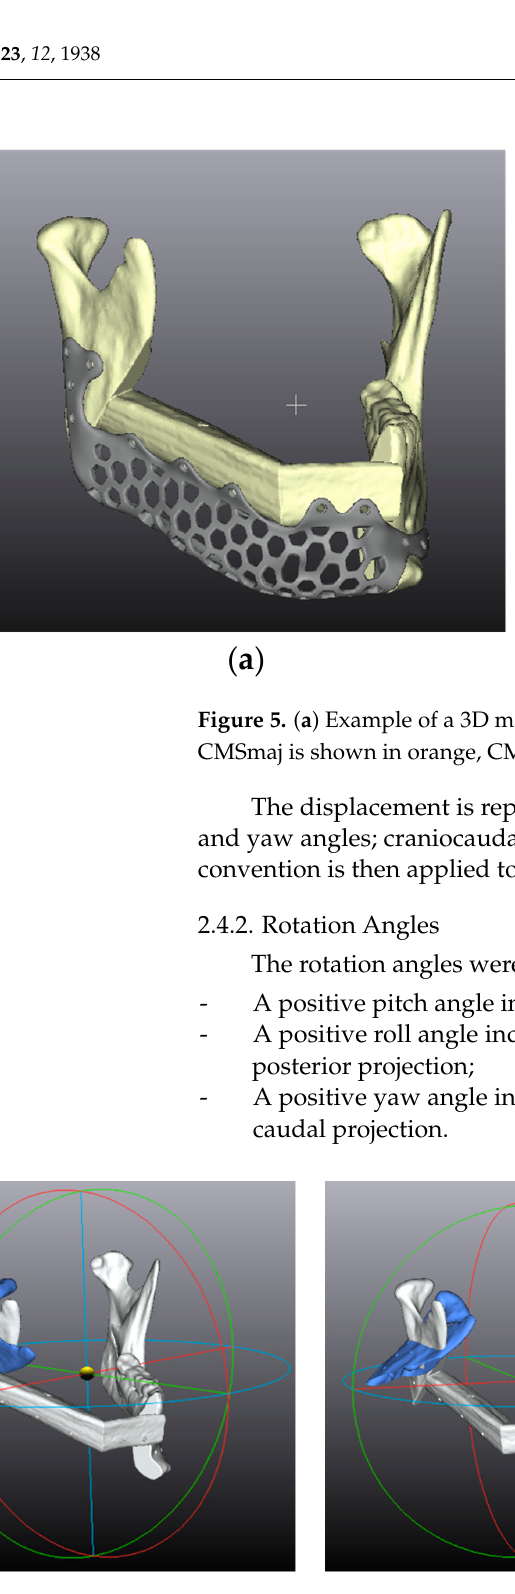
Figure 6. Examples of translation angles obtained with arbitrary values (50°): from left to right, pitch, roll, and yaw.